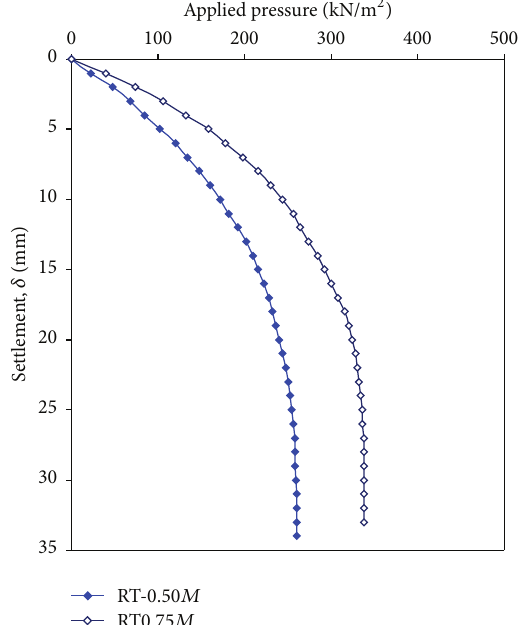
Figure 7: Load-settlement curve for reference tests, comparison.